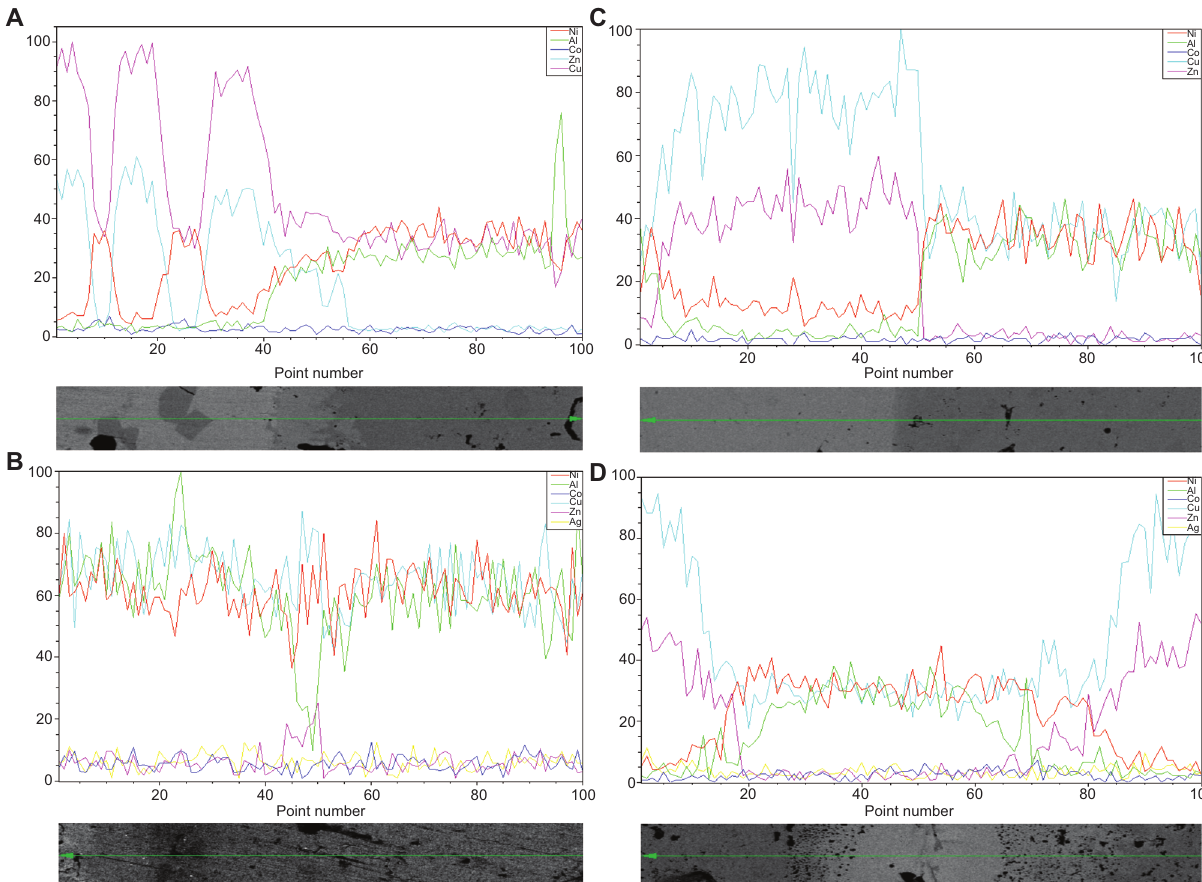
Figure 8 EDX line analysis images from Ni+Al+% 3 Co brazed for 15 min. (A) Traditional furnace with a S2 brazing alloy; (B) traditional furnace with a S28 brazing alloy; (C) microwave furnace with a S2 brazing alloy; (D) microwave furnace with a S28 brazing